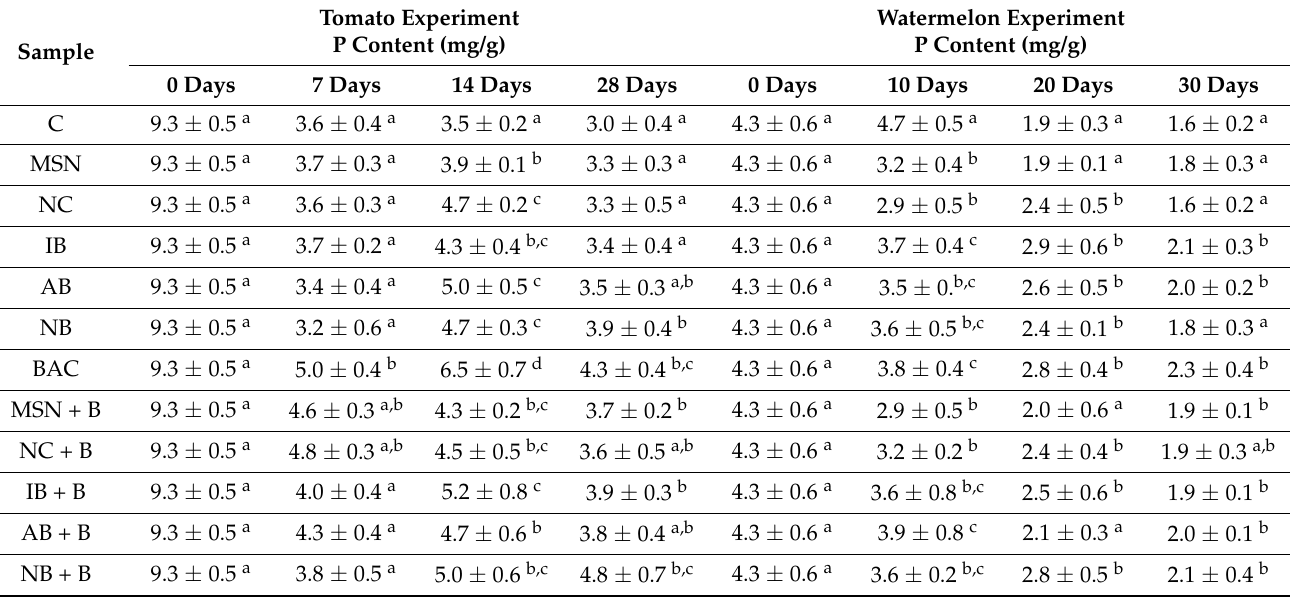
Table 2. P content (mg/g) in the 2nd tomato experiment and watermelon experiment